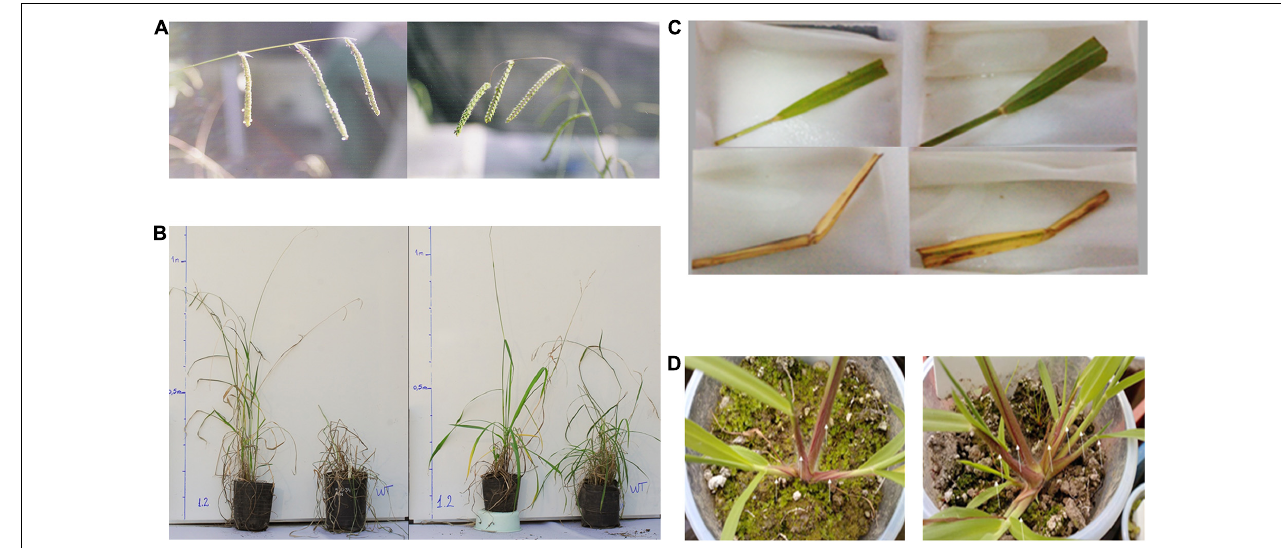
FIGURE 4 | (A) Transgenic event with tolerance to biotic stress: Dallisgrass inflorescences 15 days after inoculation with C. paspali , (left) control, (right) transgenic plant expressing chitinase (pUbi:Chi5B). Source: (Schrauf et al., 2021). (B) Transgenic event with tolerance to abiotic stress: Acquisition of tolerance to salinity through overexpression of a sodium or proton vacuolar antiporter (left) transgenic plant Atnhx1 vs. wild-type plant under saline condition, (right) both under non-saline condition. Source: Schrauf et al. (2020). (C,D ) Transgenic events of delayed senescence. (C) Comparison of senescence of excised leaves of (upper) transgenic Atmyb32:ipt plants with (below) wild-type plants. (D) Comparison of initial tillering between (left) wild-type and (right) transgenic Atmyb32:ipt plants. Source: Voda